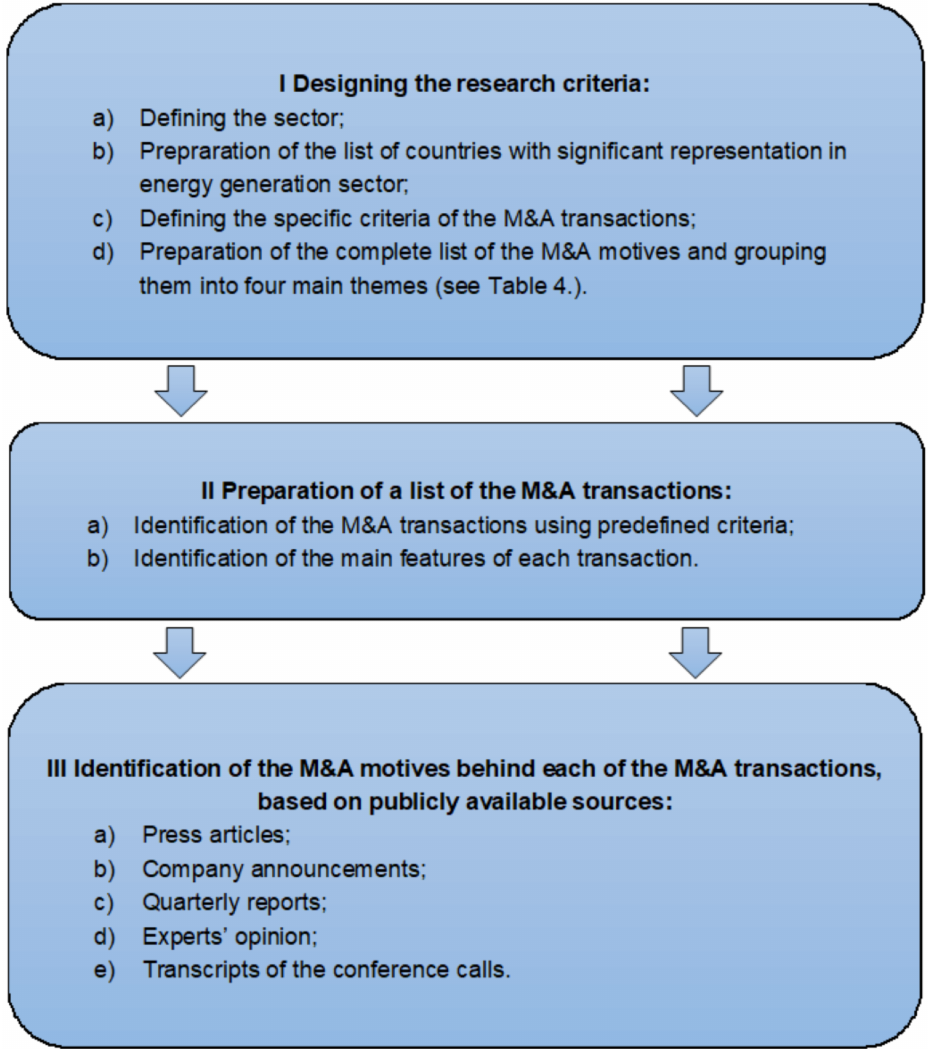
Figure 1. Research procedure. Source: